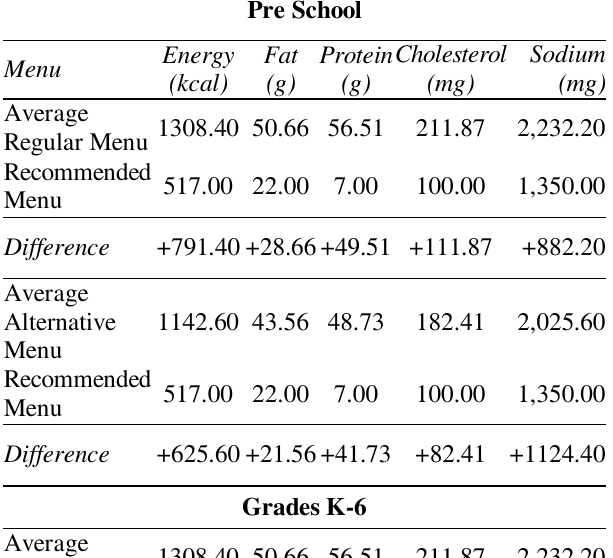
Table 5: Comparison of the school lunch menus of Jackson Public Schools with the recommended nutrients for